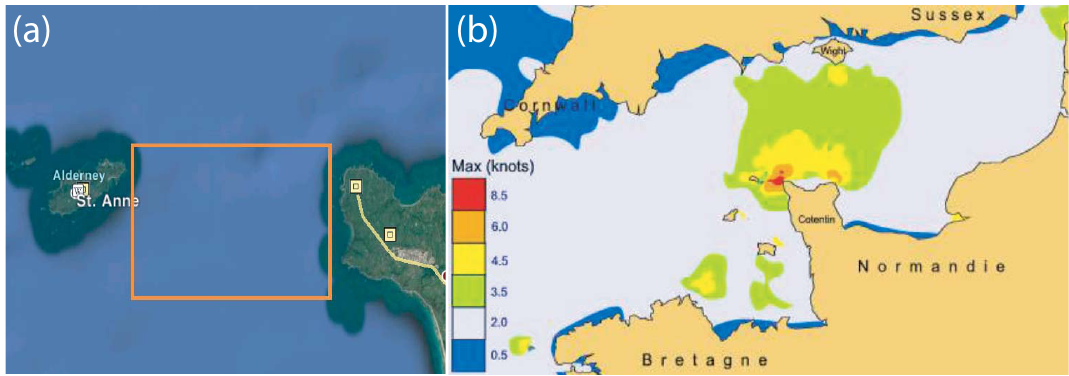
Figure 5. Alderney Race: ( a ) delimited zone for the tidal farm; ( b ) current velocity in the Alderney